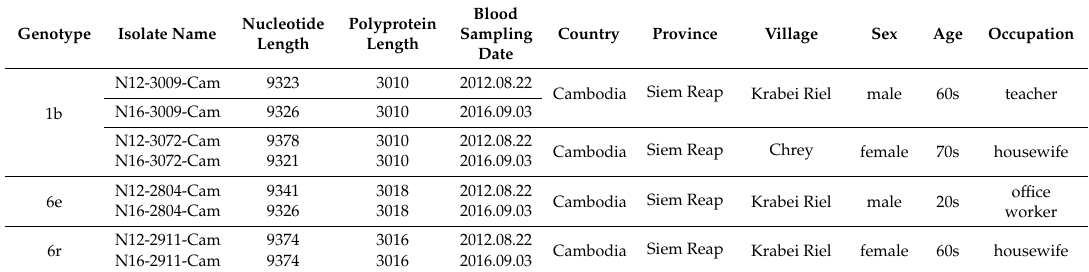
Table 1. Characteristics of positive samples collected from Cambodia.